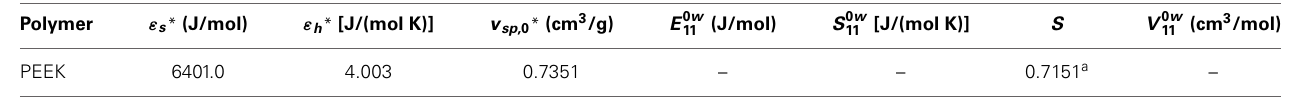
Table 3 | NRHB parameters for PEEK.